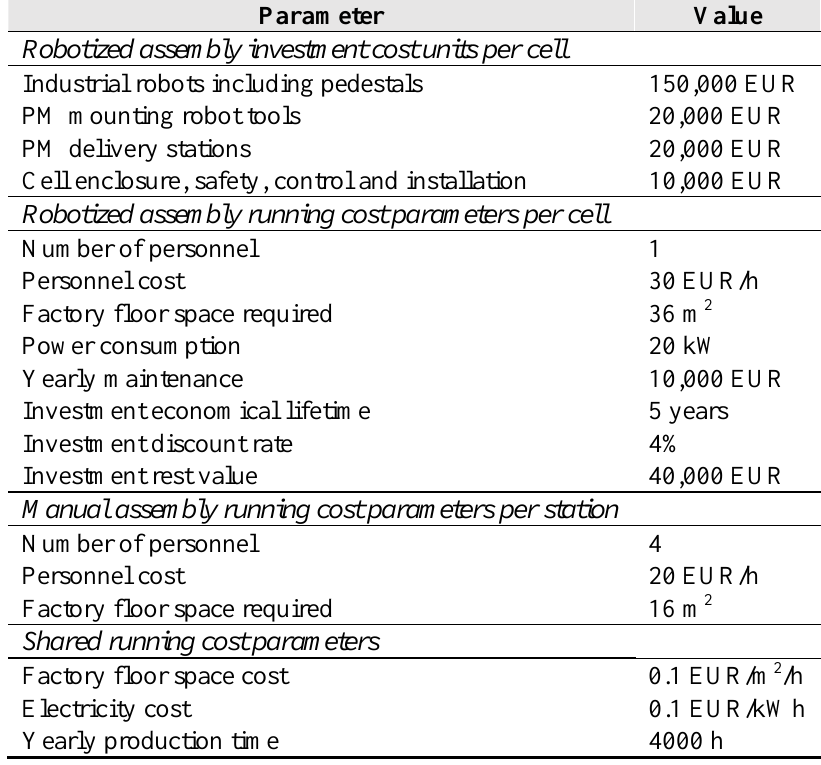
Table 1. Investment costs and running costs for robotized and manual PM assembly.